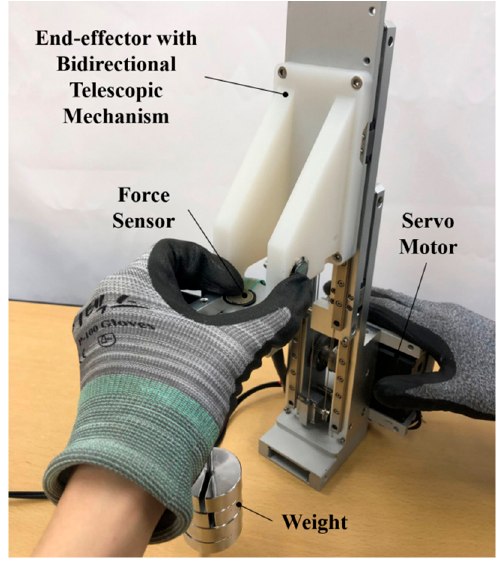
Figure 9. Experimental apparatus.